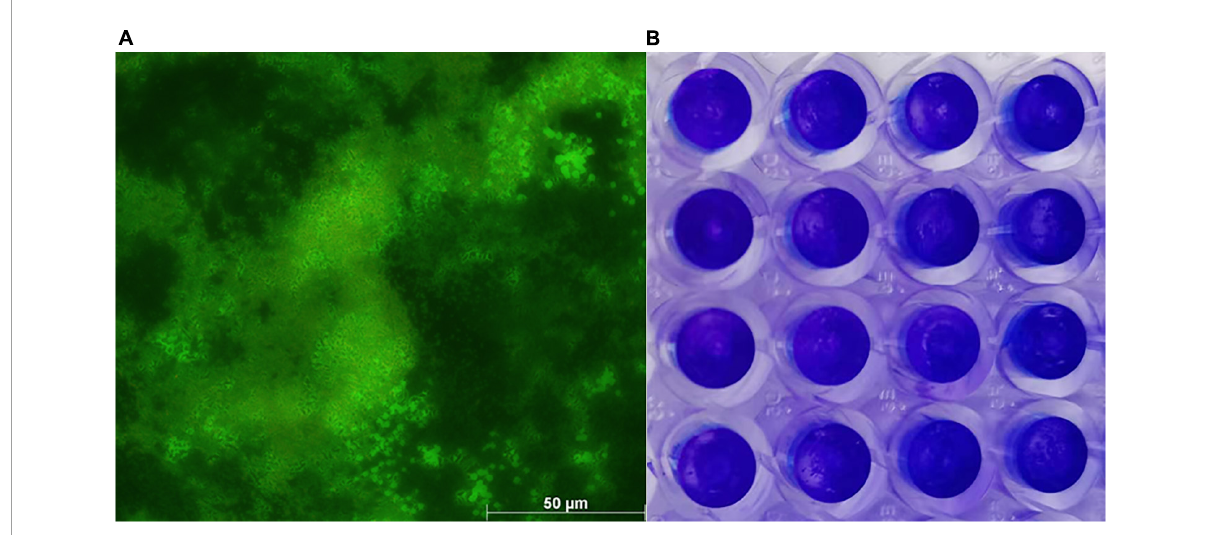
FIGURE6 Dickeya zeae strain WH1 biofilms. (A) Images are presentative of D. zeae strain WH1 biofilm grown on a glass coverslip in a 48-well plate for 20 h, scale bar 50 µ m; (B) biofilm developed in a 96-well plate for 20 h was stained with 0.1% crystal violet.